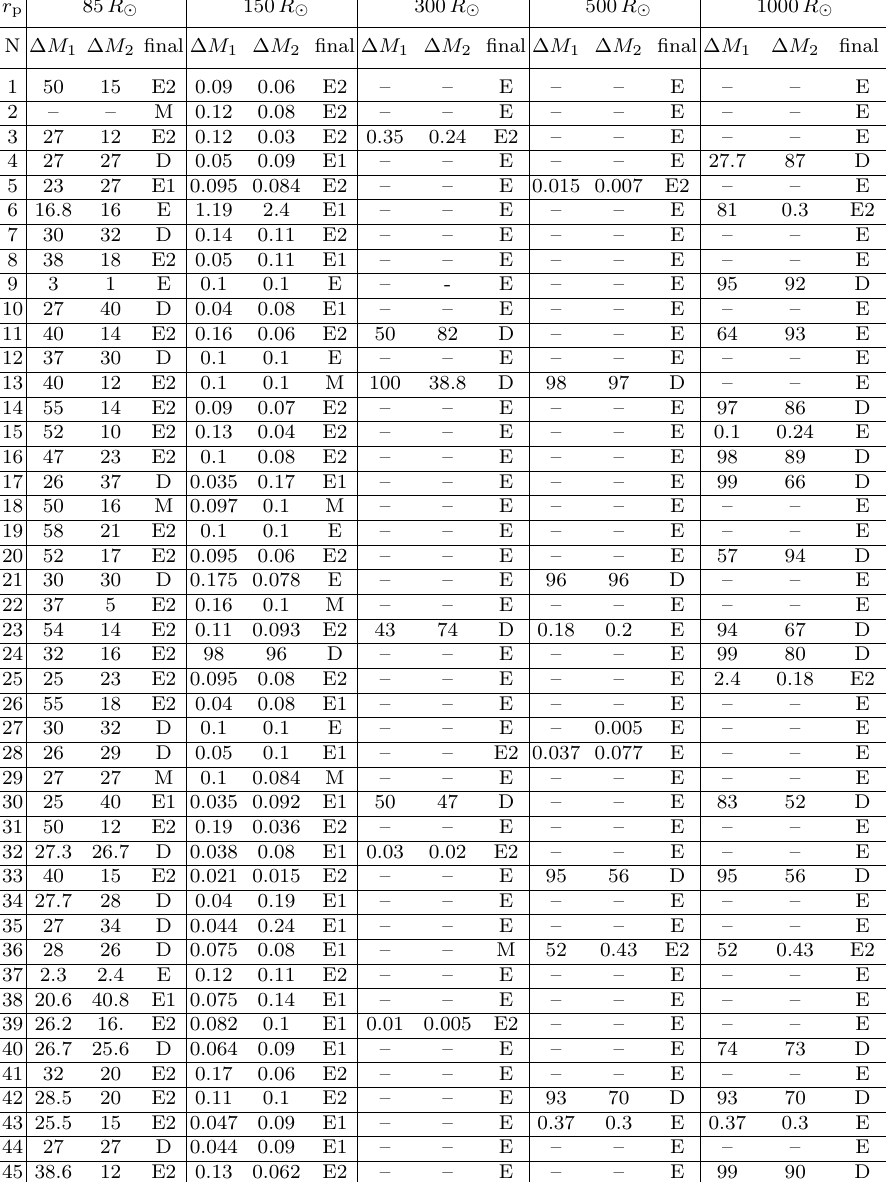
Table 2. Disruption characteristics of the CBS components (MR Cyg being the prototype) passing near a super-massive black hole with a mass of a million solar masses at pericentric distances r p = 85 R ⊙ , 150 R ⊙ , 300 R ⊙ , 500 R ⊙ and 1000 R ⊙ and the probability estimate of the HVS survival depending on r p . For other designations, see the